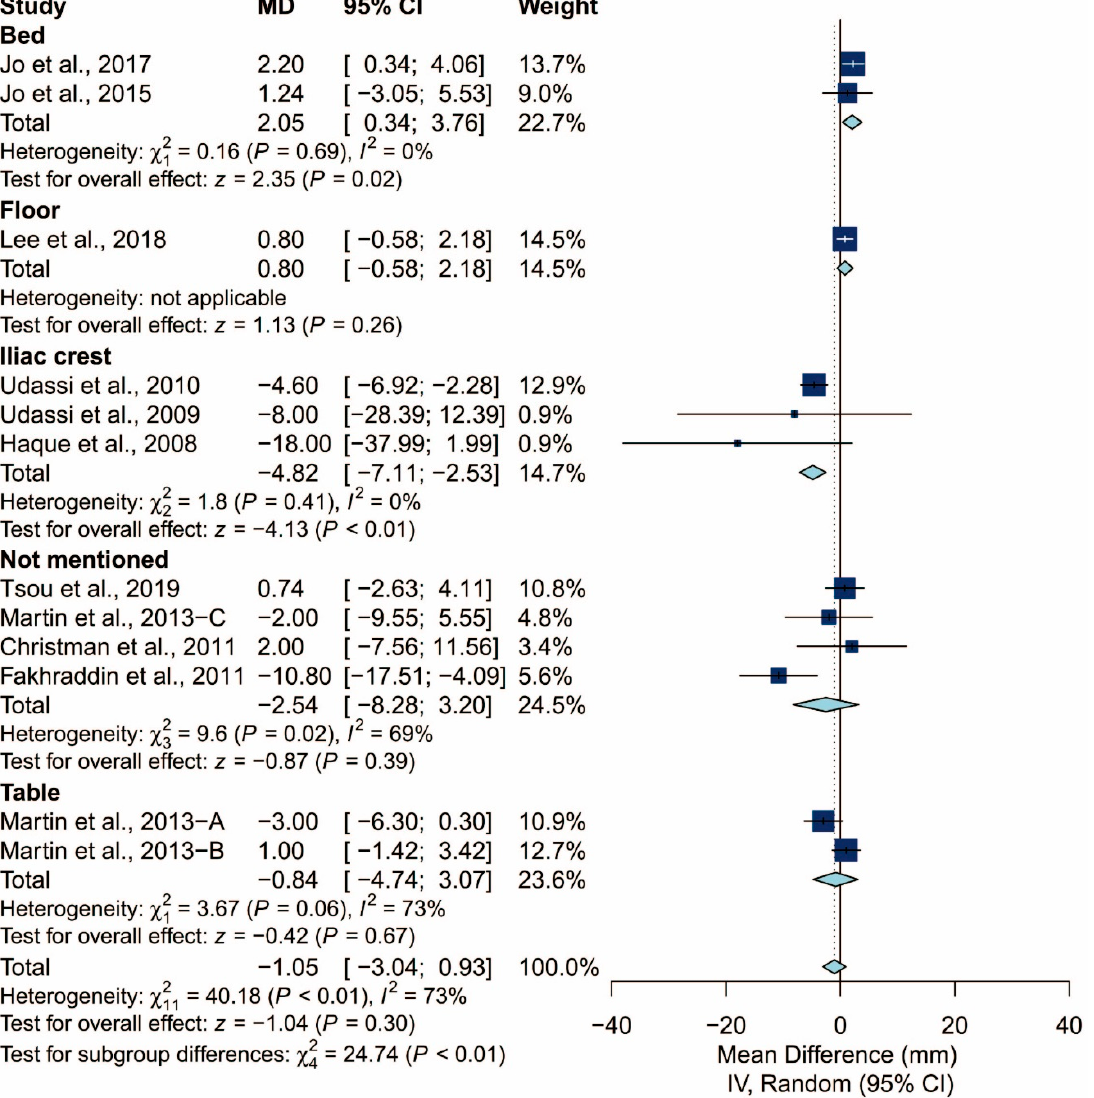
Figure 6. Subgroup analysis of chest compression rate grouped by locale.